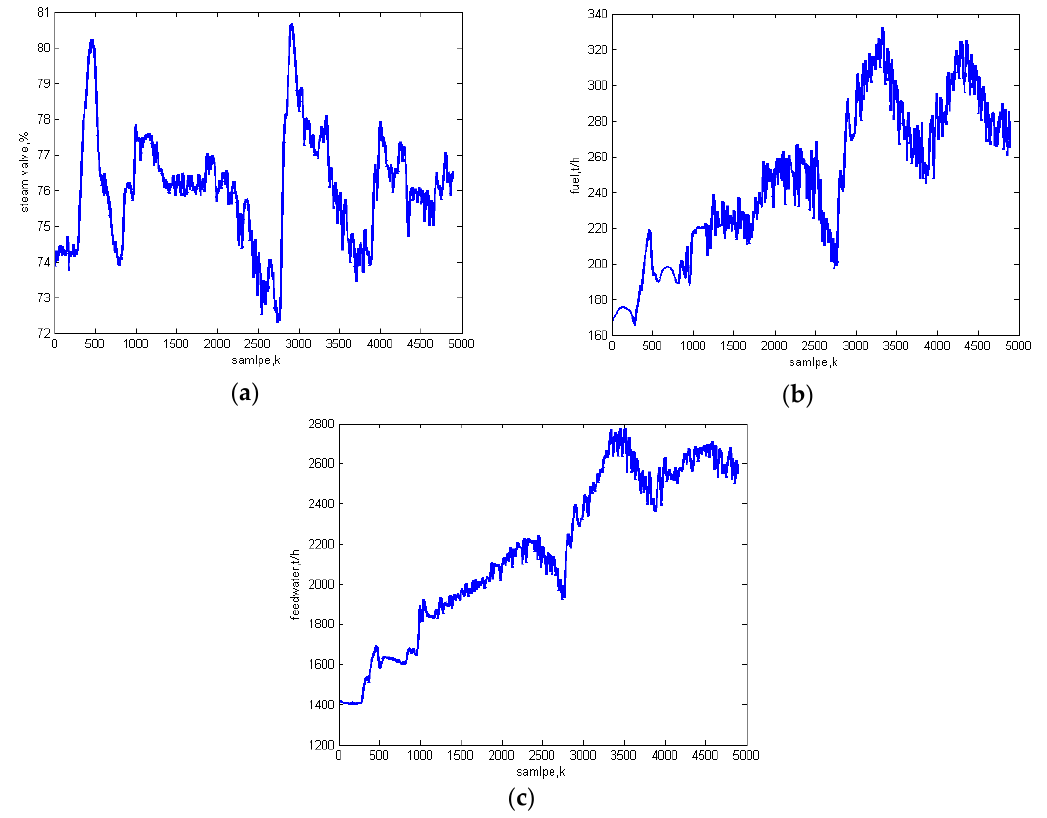
Figure 3. ( a ) Data of steam valve degree of opening; ( b ) Data of fuel; ( c ) Data of the feed ‐ water flow.